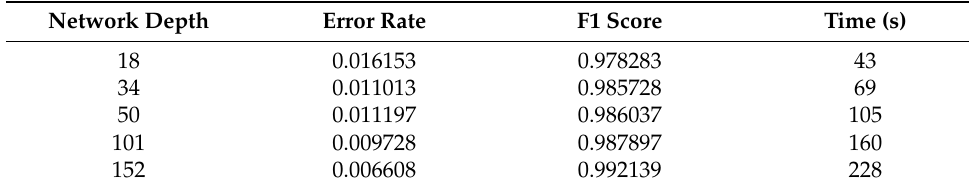
Table 8. Network depth on validation split =